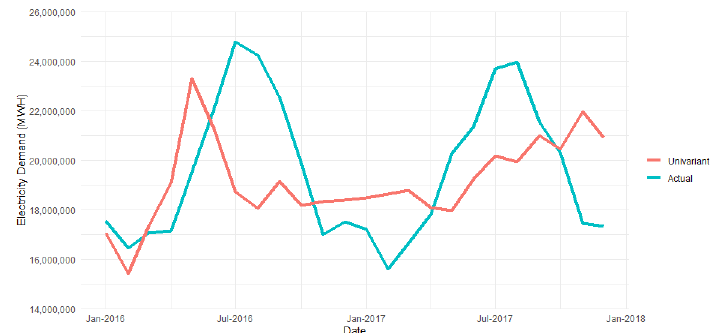
Figure 9. Actual vs. predicted univariant CNN.